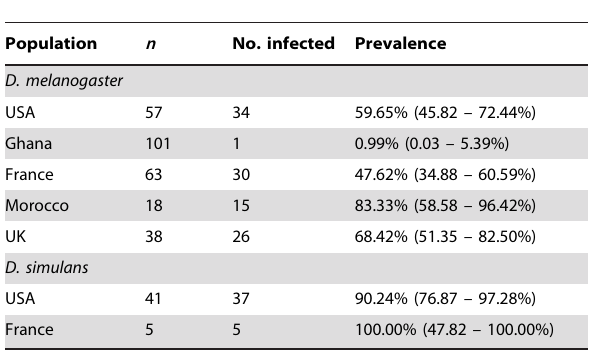
Table 1. Infection status of females in five populations of D. melanogaster and two populations of D. simulans for the bacterial endosymbiont Wolbachia